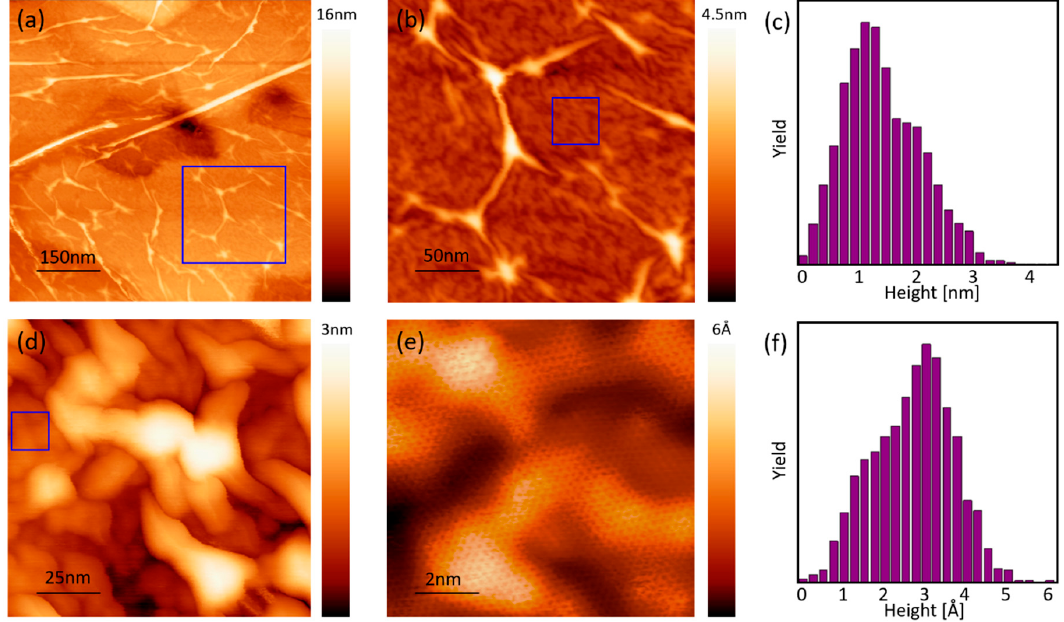
Figure 4. Closer analysis of roughness in graphene transferred onto gold samples at different scales using STM images. ( a ) 750 × 750 nm 2 , I = 0.1 nA, V BIAS = 0.6 V, ( b ) 375 × 375 nm 2 , I = 0.1 nA, V BIAS = 0.6 V, ( c ) roughness analysis of areas with wrinkles and ripples (Figure 4b), ( d ) 180 × 180 nm 2 , I = 0.03 nA, V BIAS = 0.9 V and ( e ) 20 × 20 nm 2 , I = 0.03 nA, V BIAS = 0.9 V, ( f ) roughness analysis in areas with ripples only (Figure 4d).